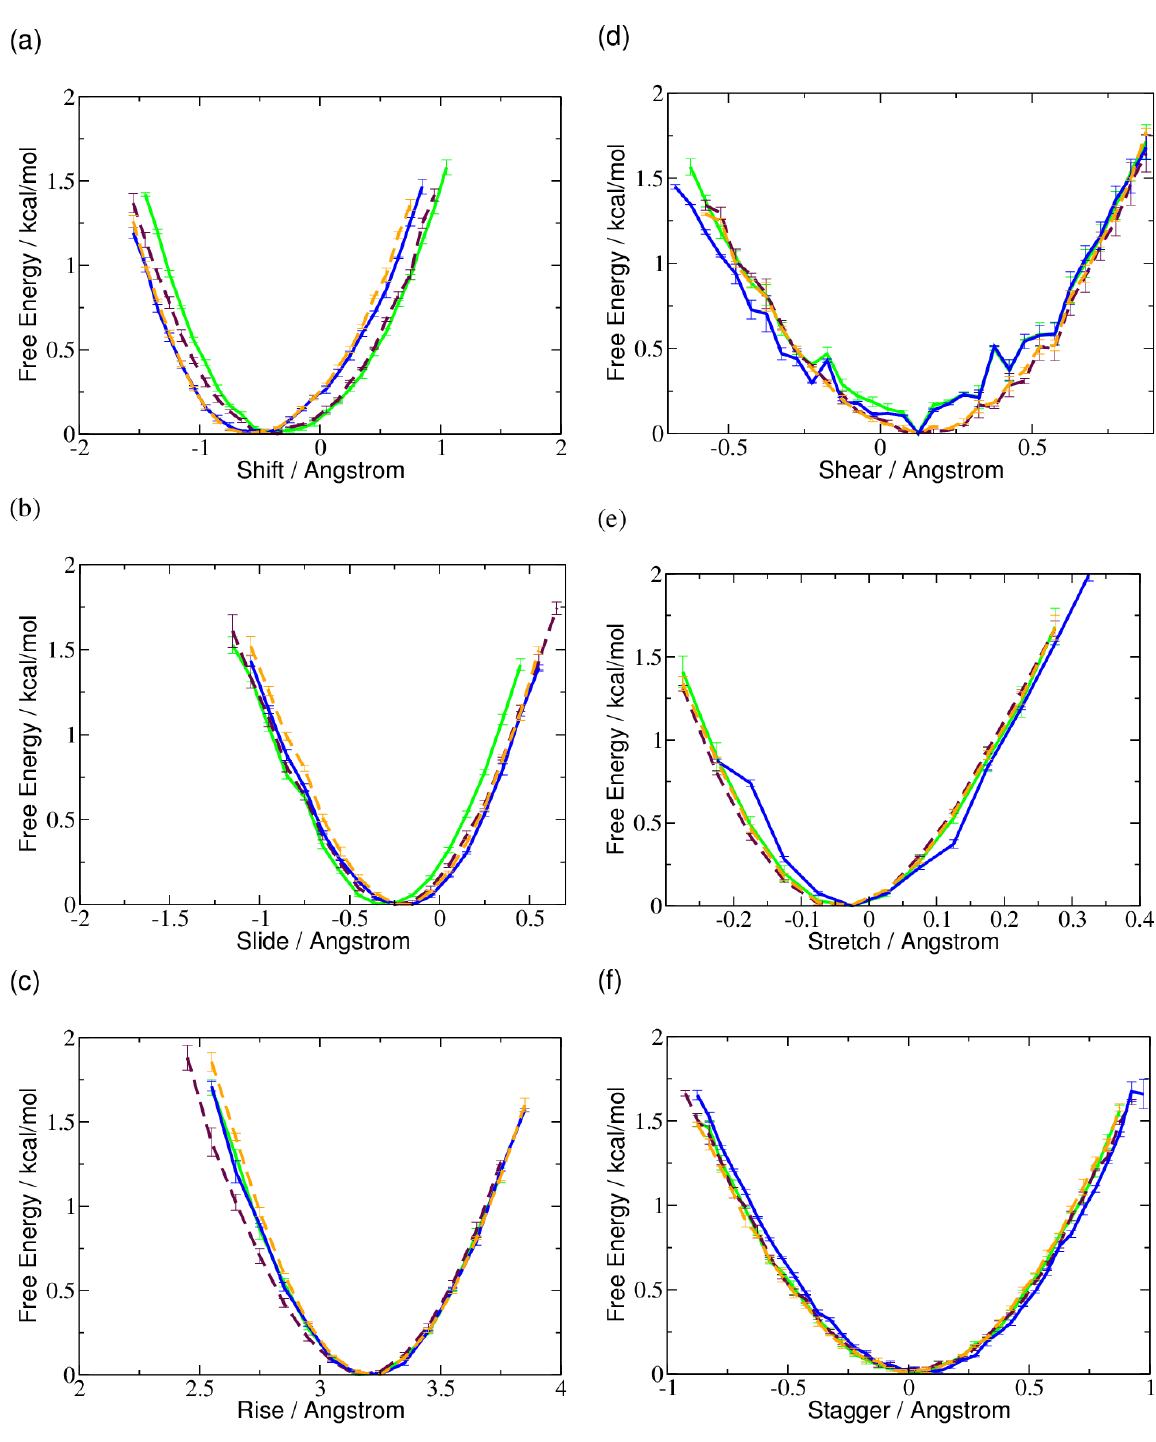
Figure 2. Free energy profiles of local helical translational parameters of 5-methyl-cytosine (green), 5-hydroxymethyl-cytosine (maroon), 5-formyl-cytosine (blue), and 5-carboxyl- cytosine (orange), respectively: ( a ) shift; ( b ) slide; ( c ) rise; ( d ) shear; ( e ) stretch; and ( f )